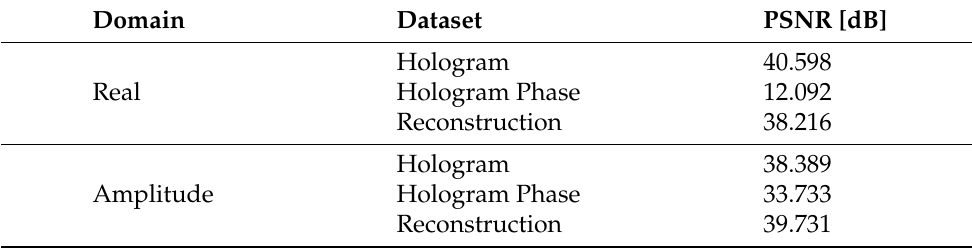
Table 2. Invisibility of the hologram and reconstruction without reconstruction in